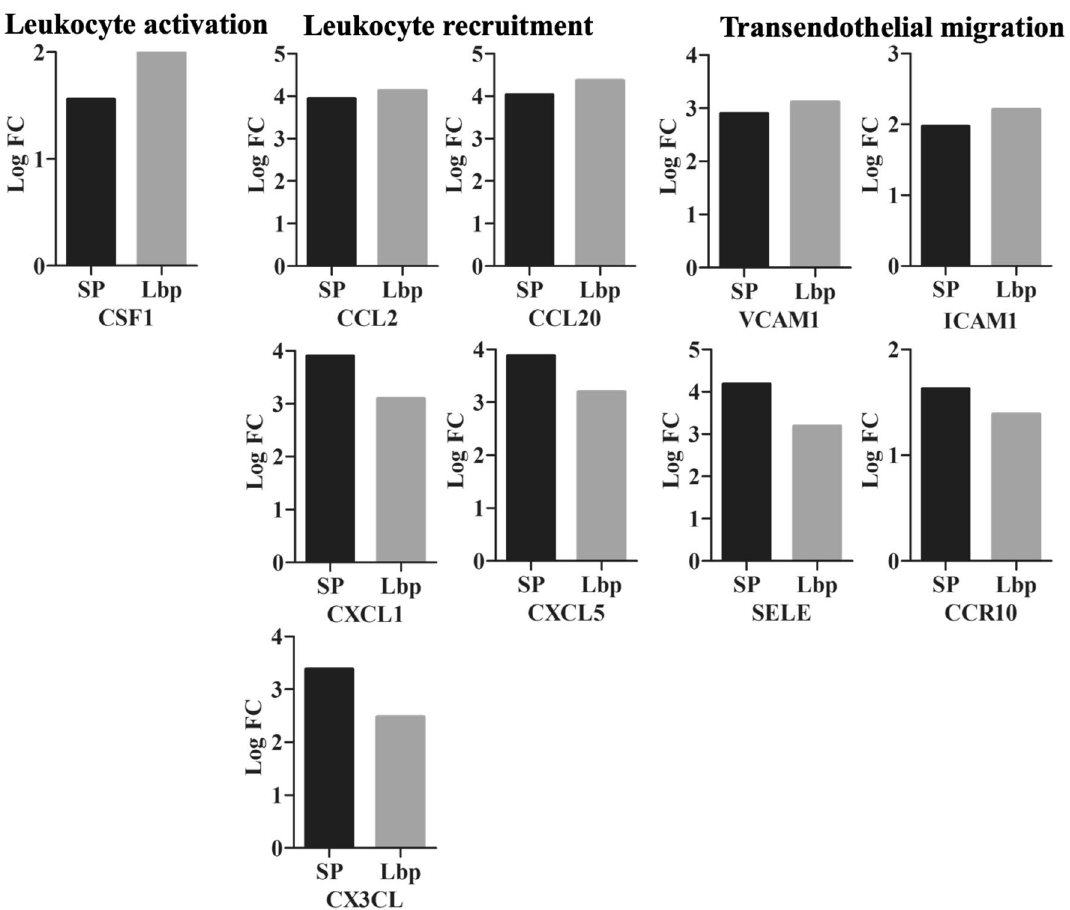
Figure 4. DEGs involved in the leucocyte recruitment, activation and transendothelial migration. Gene expression (LogFC values) of differentially expressed genes belonging to CXCL, CCL and TNF families participating in the leucocyte recruitment, activation and transendothelial migration are represented as bars. Black bars indicate DEGs identified in the S. pneumoniae -induced transcriptome and gray bars indicate